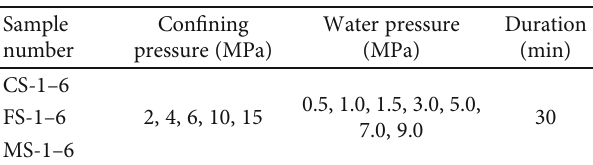
Figure 8: Relationship between Q and t ð σ